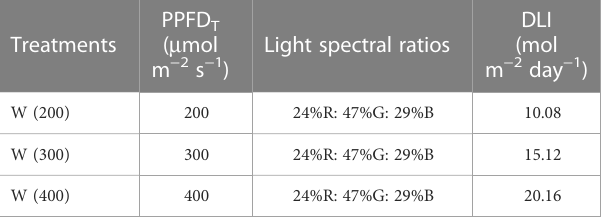
TABLE 1 Proprieties of the treatments applied in experiment 1.